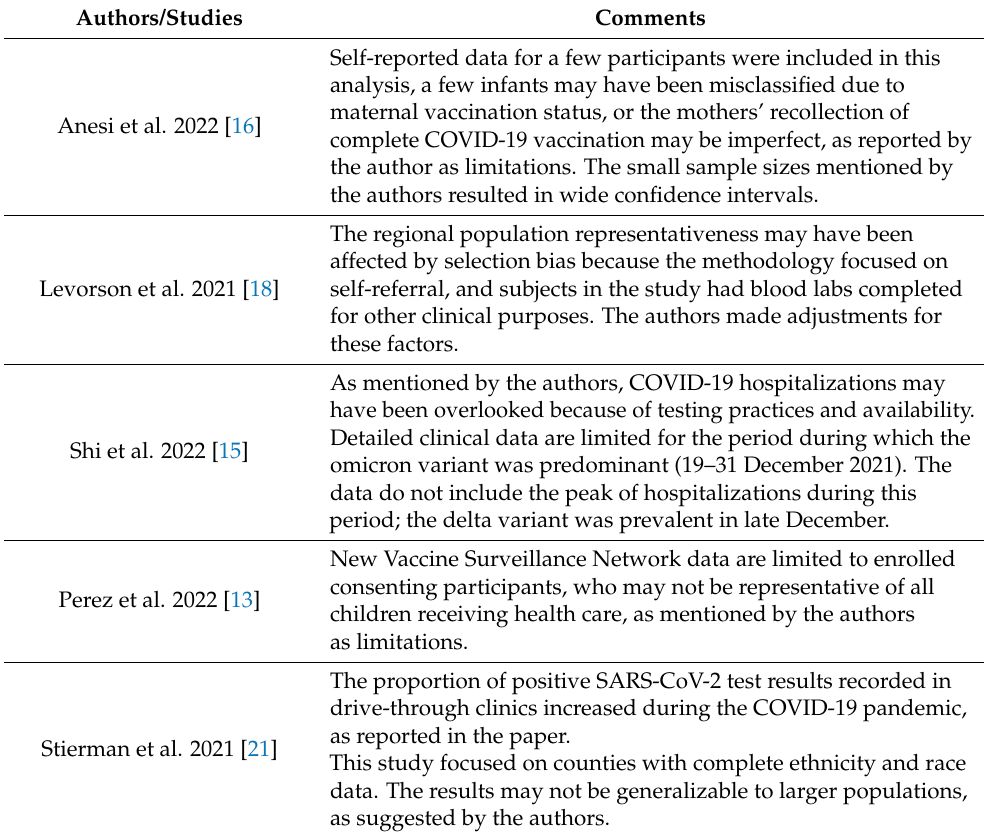
Figure 5. Risk-of-bias summary for 10 reviewed studies [15–19,21,23,25,26,33]. Table 4. Comments on risk of Table 4. Comments on risk of bias.